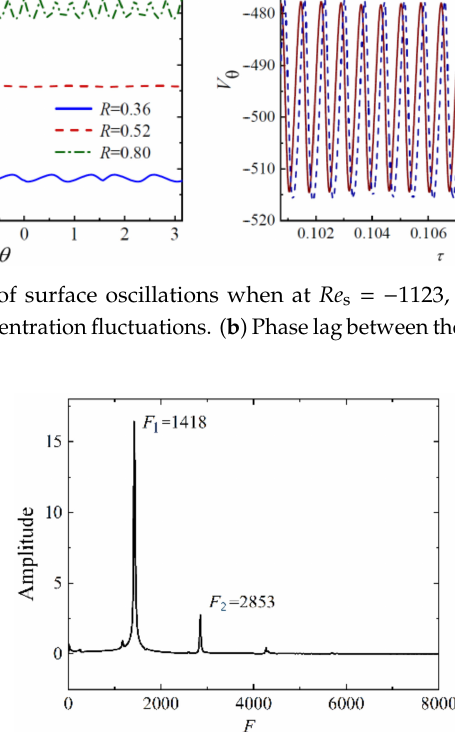
Figure 12. Fourier spectra analysis of the concentration oscillation when Re s = –1123, Re T = 7887.